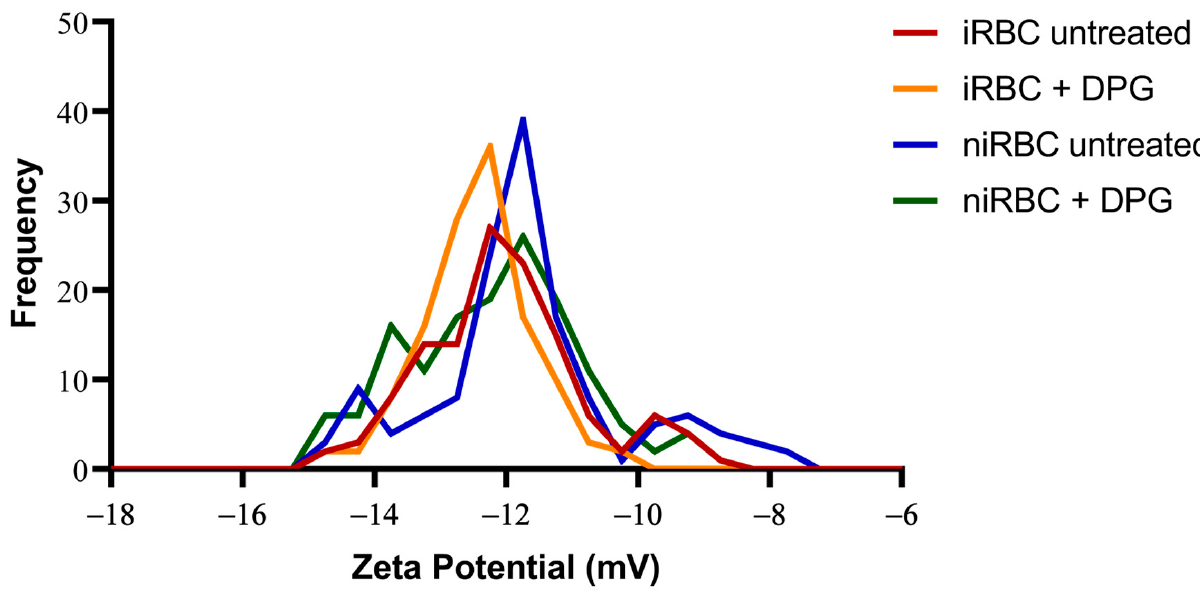
Figure 5. Histograms of the zeta potential of infected cultures and noninfected RBCs untreated or treated with 2,3-DPG for 30 h. Parasites in infected samples were at the trophozoite stage. This figure includes data from three independent experiments. iRBC + DPG—cultures with infected RBCs treated with 2,3-DPG ( n = 124); iRBC untreated—cultures with infected RBCs untreated ( n = 125); niRBC + DPG—noninfected RBCs treated with 2,3-DPG ( n = 143); niRBC untreated—untreated noninfected RBCs ( n = 139). (